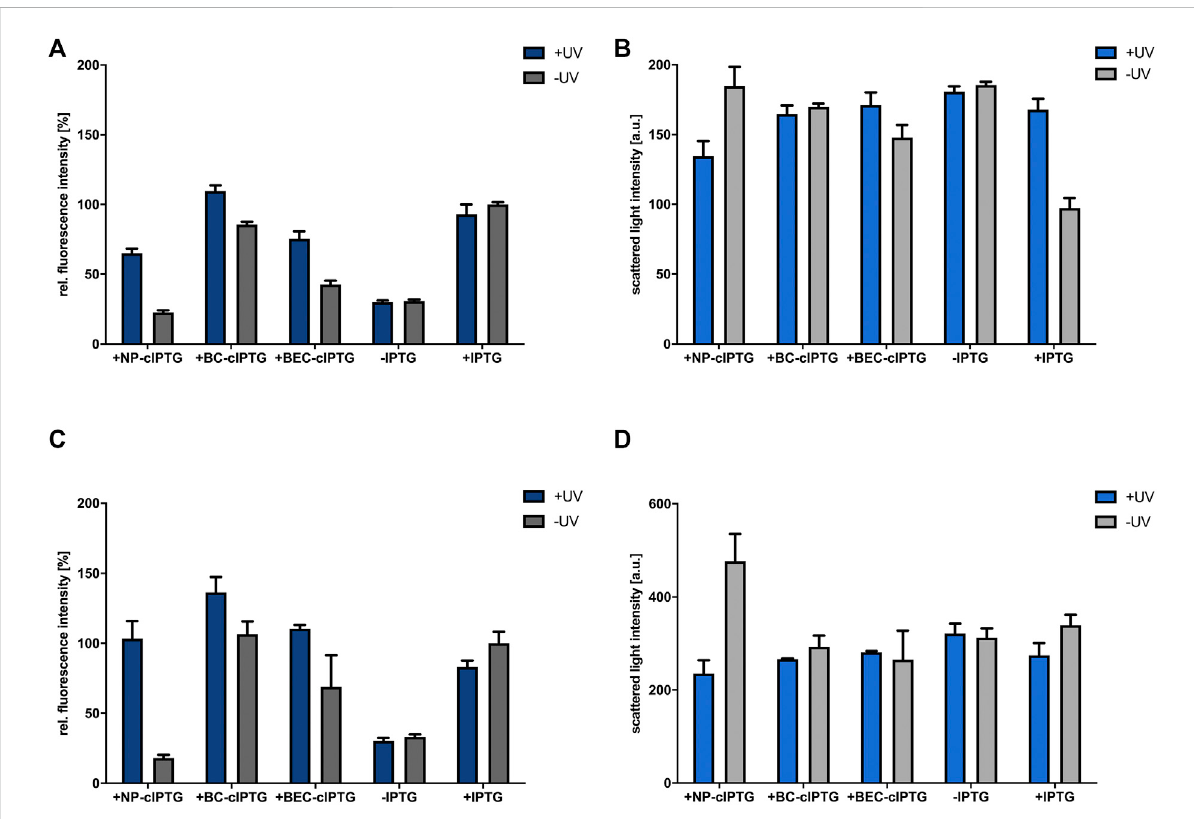
FIGURE 2 Application of cIPTG derivatives for light-mediated control of gene expression in R. capsulatus under non-phototrophic conditions. Light- controlled eyfp reporter gene expression and corresponding cell densities in aerobically (A,B) and microaerobically (C,D) grown R. capsulatus SB1003 cultures carrying pRholHi-2-eYFP using the three cIPTG derivatives NP-, BC- and BEC-cIPTG. Biomass-normalized eYFP in vivo λ λ = 620 nm) of cultures supplemented fl uorescence ( λ ex = 508 nm, em = 532 nm) and cell growth represented by the scattered light intensity ( with1 m M ofeachcIPTGvariantisshowninrelationtoacontrolculture(1 m M IPTG)after48 hofcultivation(RCVmedium,30 ° C;foraerobiccultures 800 rpm and 800 µL fi lling volume and for microaerobic cultures 400 rpm and 1,500 µL fi lling volume). Induction of reporter gene expression was performed after 9 h via UV-A light exposure at 365 nm (~1 mW/cm 2 ) for 30 min or the addition of 1 m M IPTG. (B,D) . Values are means of individual biological triplicates. Error bars indicate the respective standard